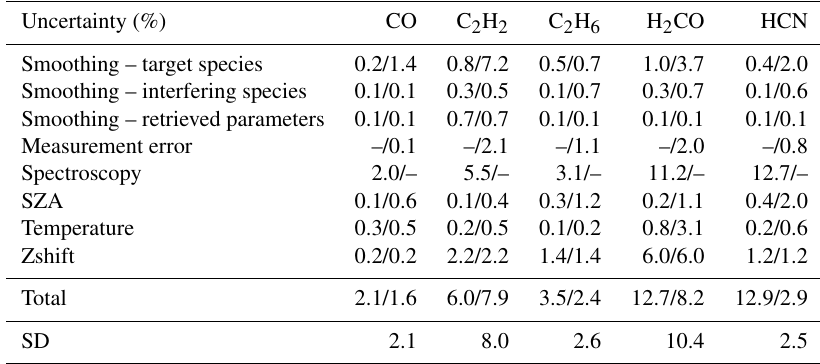
Figure 4. The upper row shows the a priori profiles (black) and retrieved profiles (solid red line: mean; dashed red area: standard deviation) for CO, C 2 H 2 , C 2 H 6 , H 2 CO, and HCN. The lower row shows the averaging kernels and the column averaging kernels (divided by 10) for these species. Table 4. The systematic and random (sys/ran) retrieval uncertainties for the total columns of five target species. The “–” means that the uncertainty is less than 0.1%. The SD of each species within ± 1h around local noon are shown in the bottom row to represent the variability of the